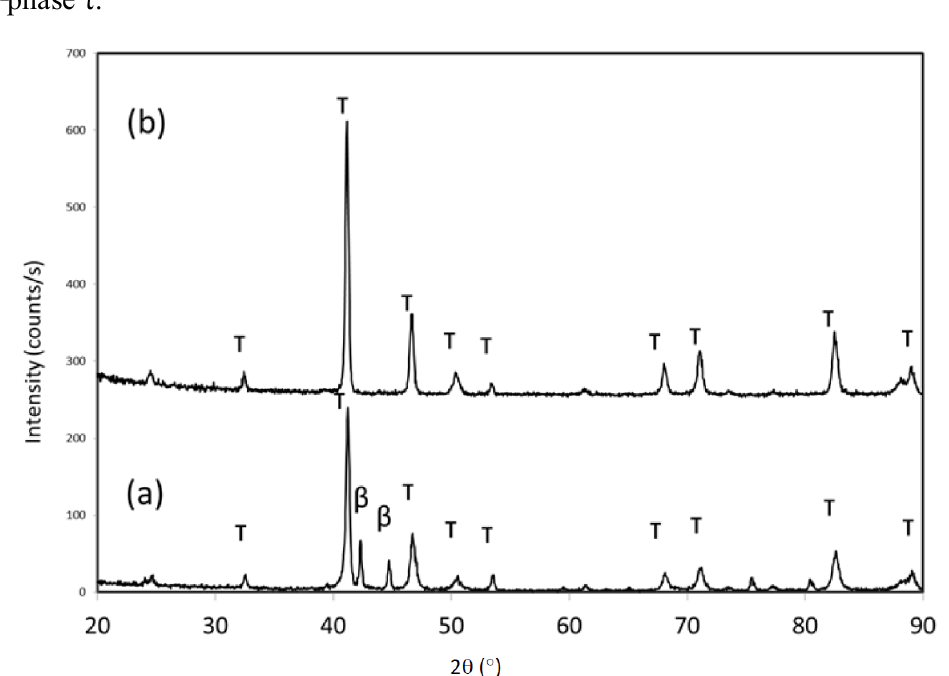
Figure 7. X-ray diffraction pattern ( a ) 1 h ε-milled sample, converted to τ showing significant phase fraction of β-Mn, and ( b ) same sample after annealing at 1050 °C to transform the material back to ε, and then conversion to τ at 500 °C for 10 min. It returns to single-phase